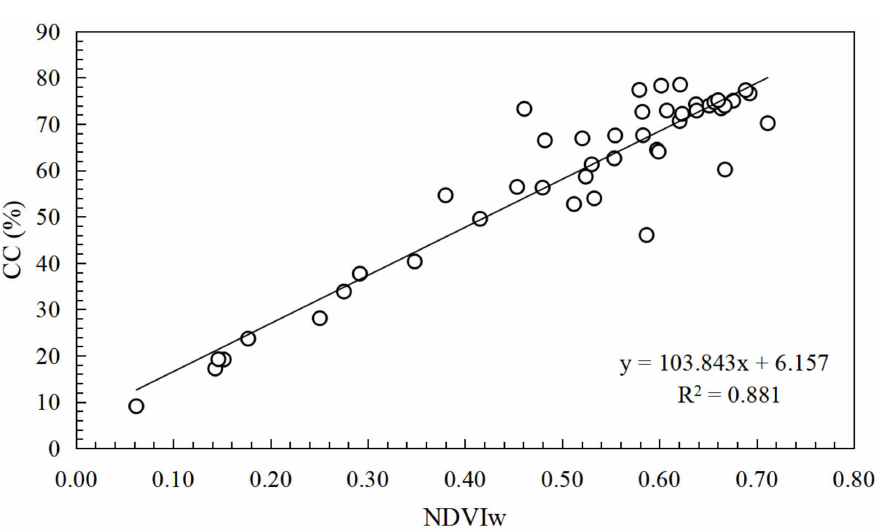
Figure 6. CC-NDVI LW model calibrated by linear regression